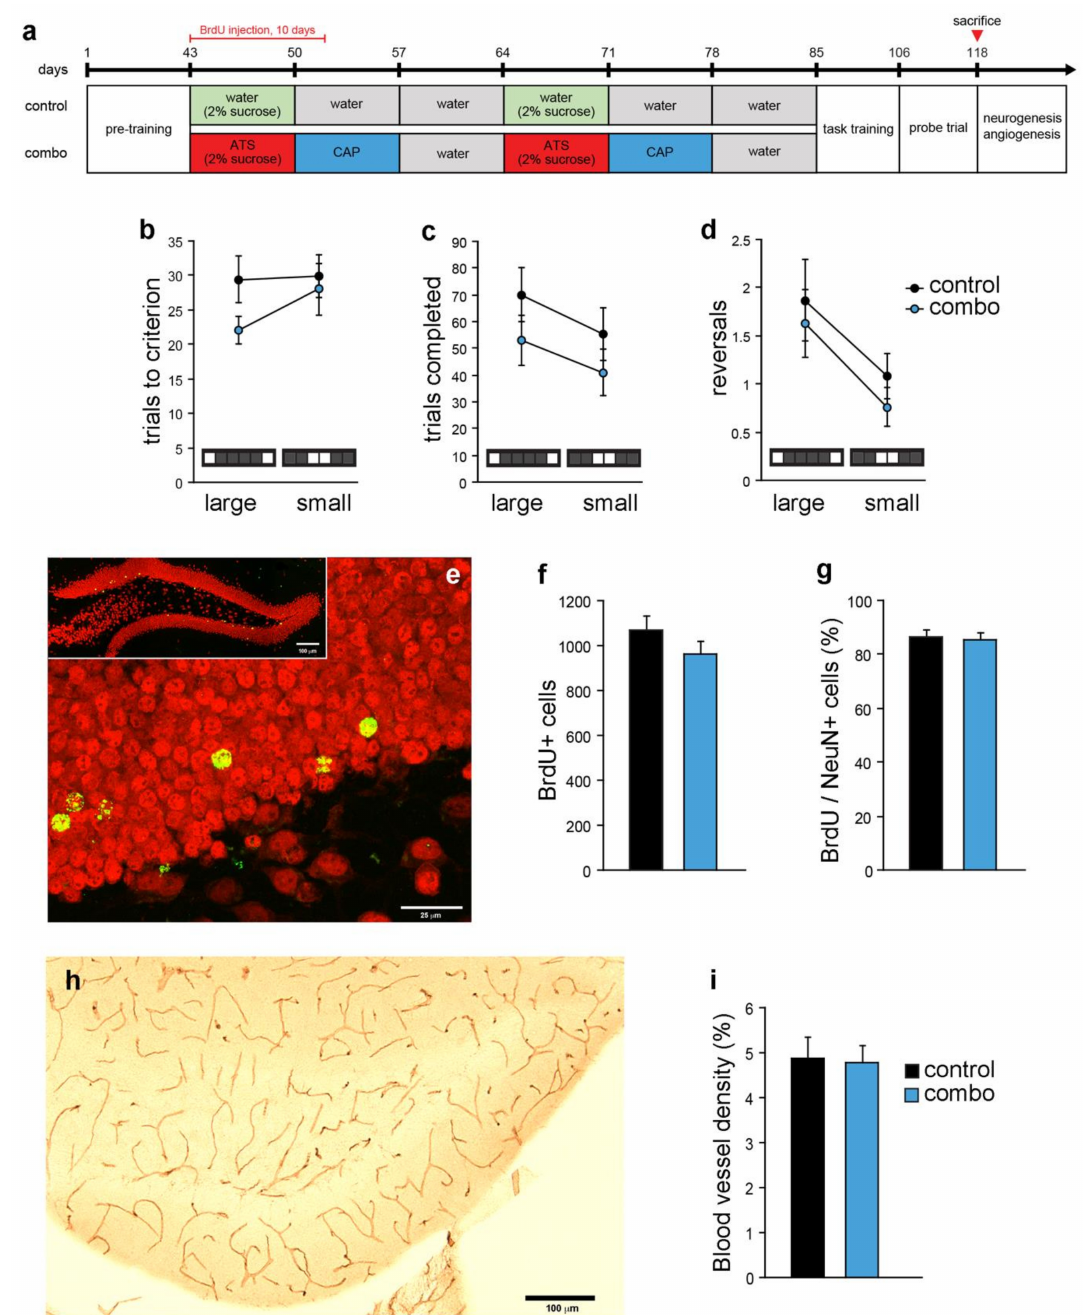
Figure 3. Effects of compound treatment on pattern separation, adult hippocampal neurogenesis and angiogenesis in the dentate gyrus in adult mice. ( a ) Compound treatment and touchscreen-based pattern separation test schedule in adult mice. After mice reached the performance criterion in pre-training, each compound was administered to mice daily for a week at a time, for two cycles. Treatment lasted a total of six weeks and both groups were given a daily i.p. injection of BrdU for the first 10 days. Following compound treatment, mice were trained again in task training until they reach performance criterion. The days to complete the task training did not differ between groups. Thereafter, both groups were tested in the probe trials for 12 days. ( b ) In the number of trials to criterion, 7 out of 8 trials correct within a session, there was no interaction between task level (small and large separation) and the groups. ( c ) Trials completed and ( d ) the number of reversals also did not differ between groups. ( e ) Photomicrograph of double-labeling for BrdU (green) and NeuN (red) in the DG. ( f ) There is no difference in the number of BrdU + cells or ( g ) in the percentage of BrdU + /NeuN + cells between the groups. ( h ) Photomicrograph of DG blood vessels stained with CD31. ( i ) DG blood vessel density did not differ between the groups. Atorvastatin, ATS; captopril, CAP; bromodeoxyuridine, BrdU; dentate gyrus, DG; NeuN, neuronal